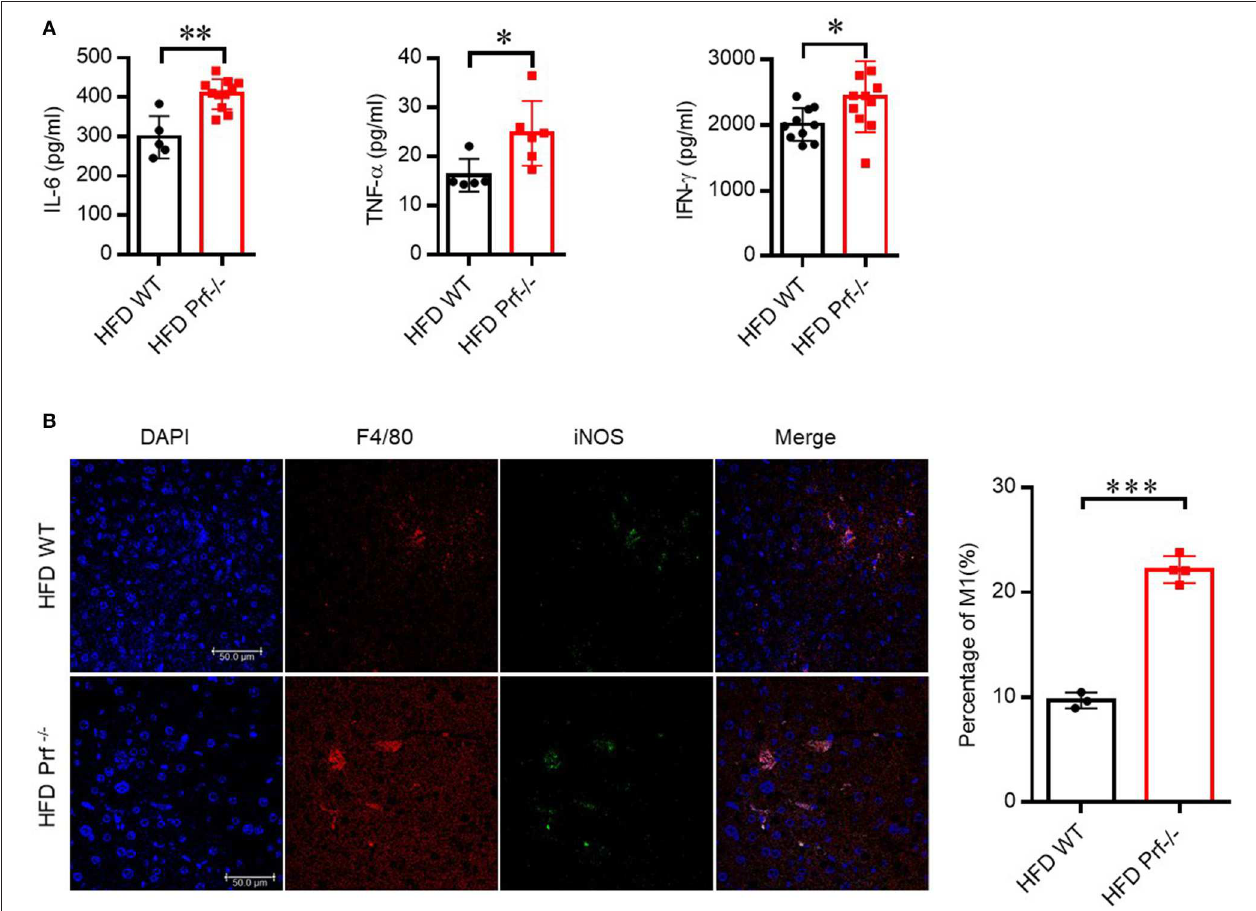
FIGURE 4 | Perforin deficiency drives the accumulation of M1 macrophages and releases of pro-inflammatory cytokines in the liver with HFD challenge. WT and Prf − / − mice were fed HFD for 10 weeks. (A) IL-6 (left panel, n = 5–11), TNF- α (middle panel, n = 5–6), and IFN- γ (right panel, n = 10–11) levels in liver supernatants. (B) Representative immunofluorescence images from liver with DAPI (blue), F4/80 (red), iNOS (green), and co-localization (merged image) (left) and the percentage of M1/M (refers to iNOS + F4/80 + cells/F4/80 + cells) was calculated (right). The data shown in each panel of the figures were collected from a single experiment, and each experiment was repeated for at least three times and rendered consistent results. Means ± SEM, * p < 0.05; ** p < 0.01; *** p <